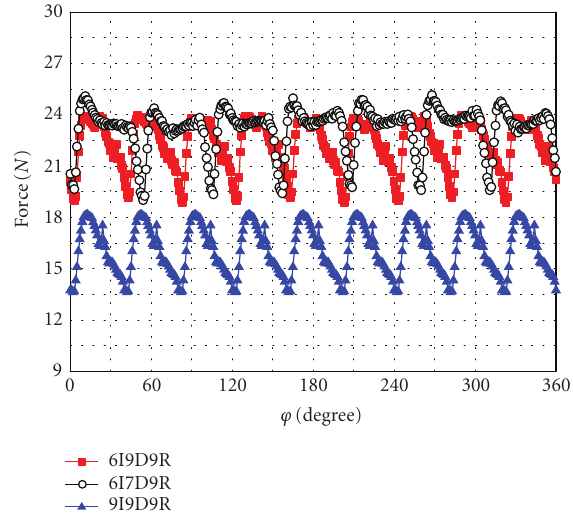
Figure 14: Comparison of total force on a single impeller blade for three blade number configurations,